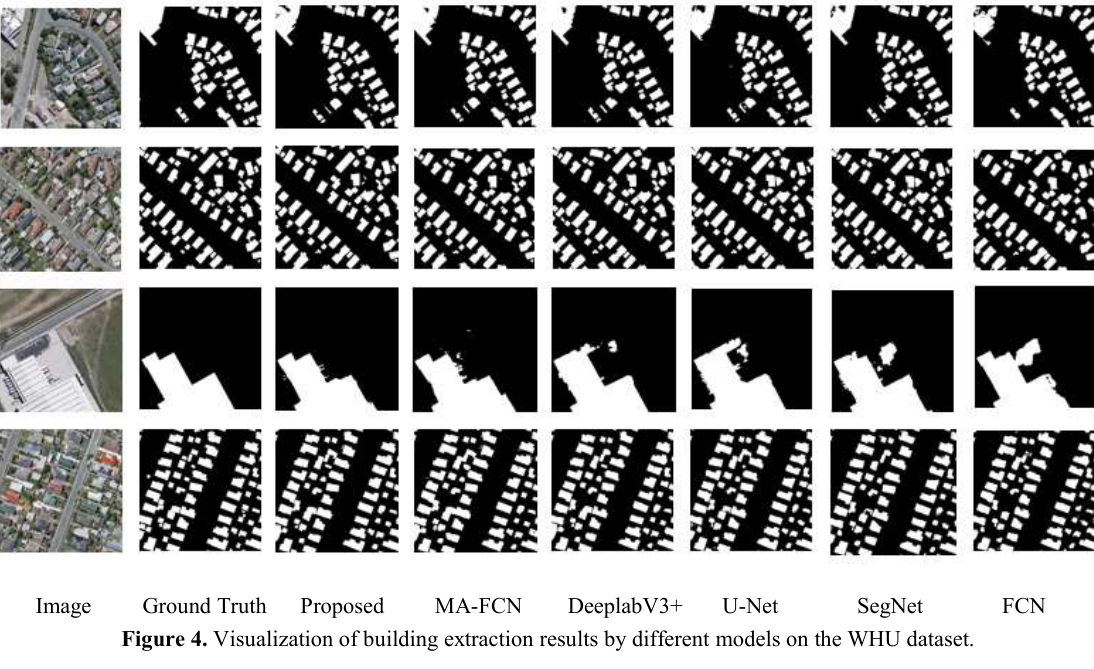
Figure 4. Visualization of building extraction results by different models on the WHU dataset.